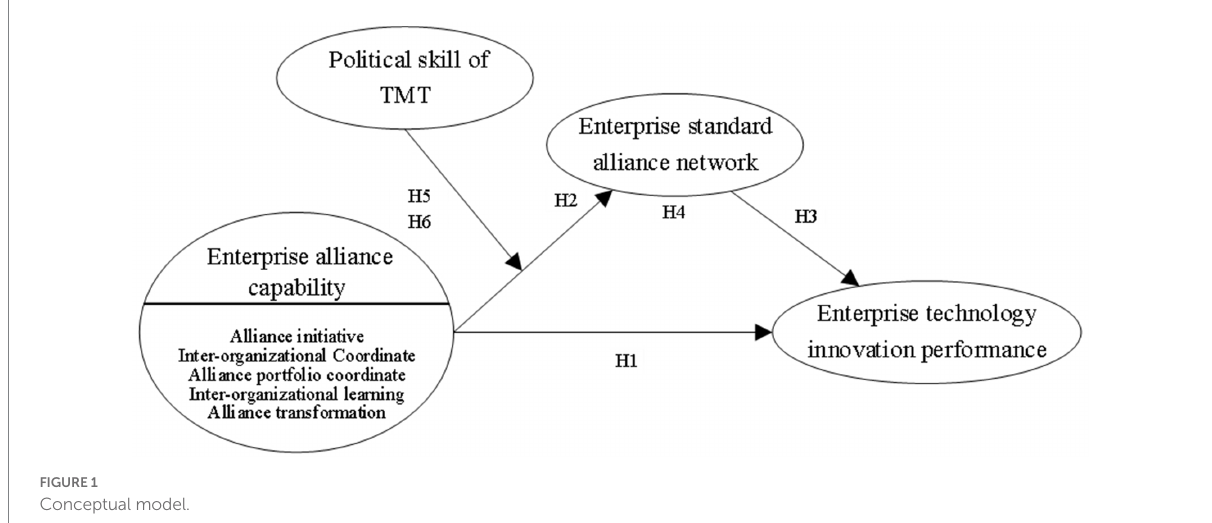
FIGURE 1 Conceptual